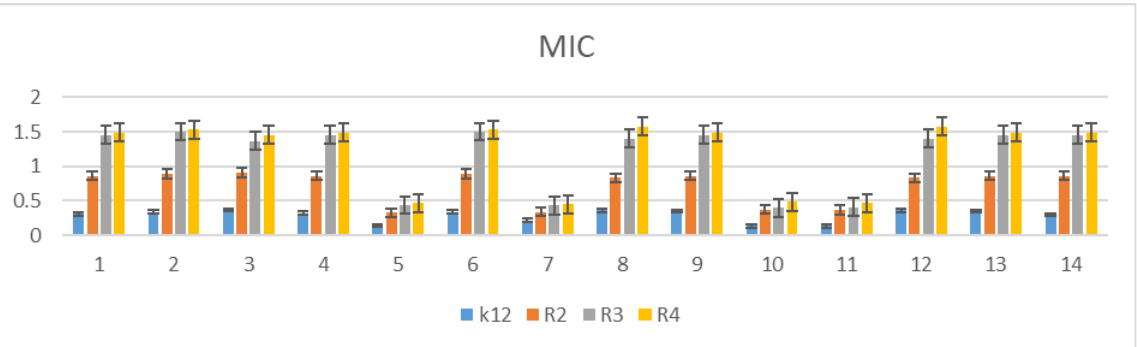
Figure 6. Minimum inhibitory concentration (MIC) of the p -quinols 1 - 10 and parent benzo- and hy- droquinones 11 – 14 in model bacterial strains. The x -axis features compounds 1 – 14 used sequentially. The y -axis shows the MIC value in µ g/mL − 1